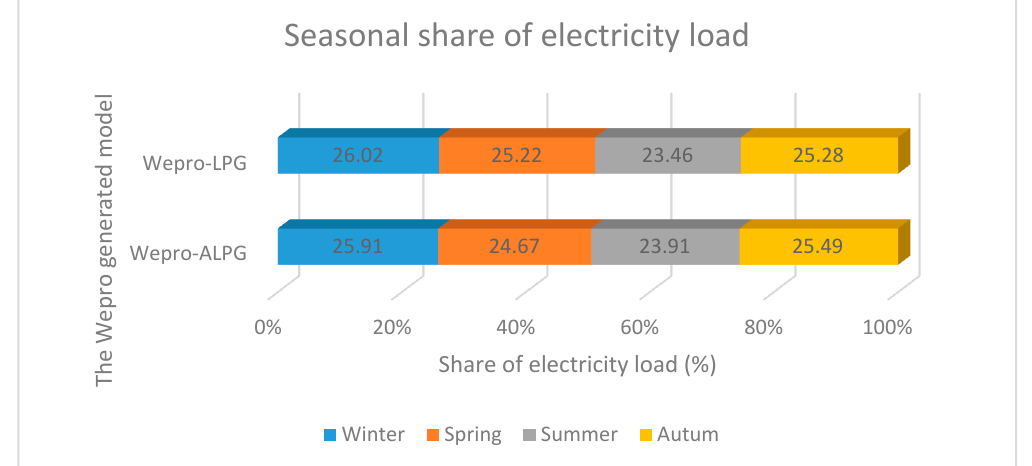
Figure 9. Seasonal share of electricity load based on the models: Wepro model-LPG and Wepro-ALPG. Both models show similar seasonal characteristics of the consumption share from the highest season to the lowest season.